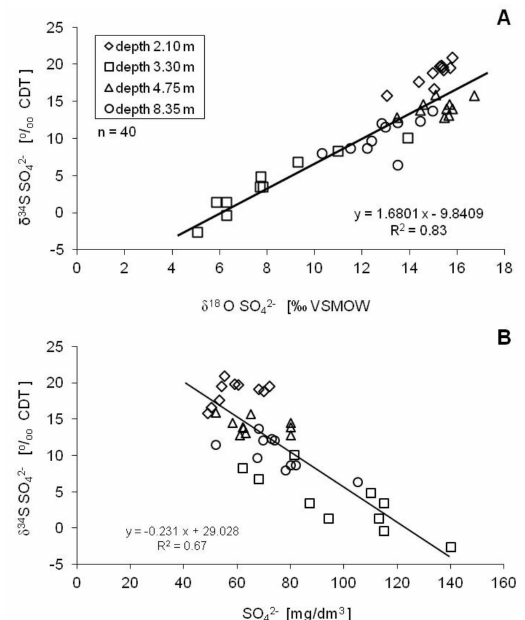
Figure 9. Trends of the δ 34 S and δ 18 O values for residual sulfates in groundwater of the Po˙zary aquifer. Linear correlations strongly suggest the occurrence of the bacterial sulfate reduction. The relationships between the fraction ( f ) of the residual sulfate and the δ 34 S and δ 18 O values of all groundwater samples from the aquifer of the Po˙zary research station are shown in Figure 10.